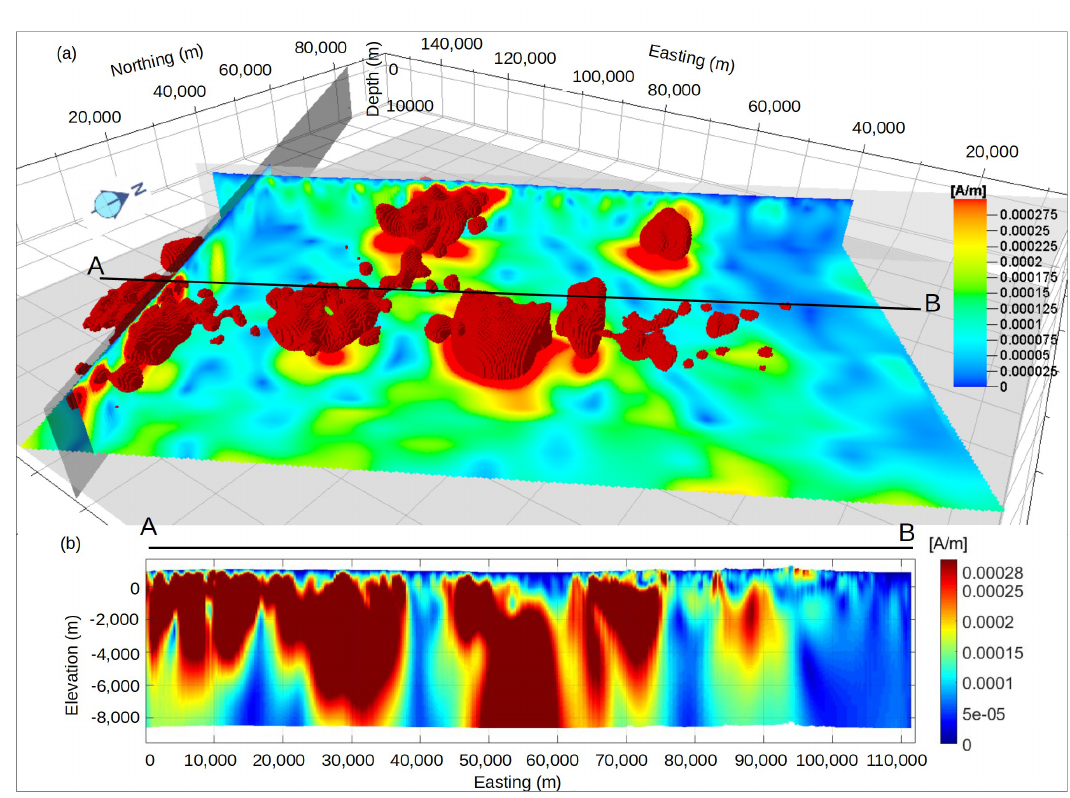
Figure 6. Magnitude of magnetic vector model recovered from the TMI data. Panel ( a ) shows a perspective image of the magnetic vector magnitude as viewed from the southeast. Panel ( b ) shows a vertical cross section of the model along line A to